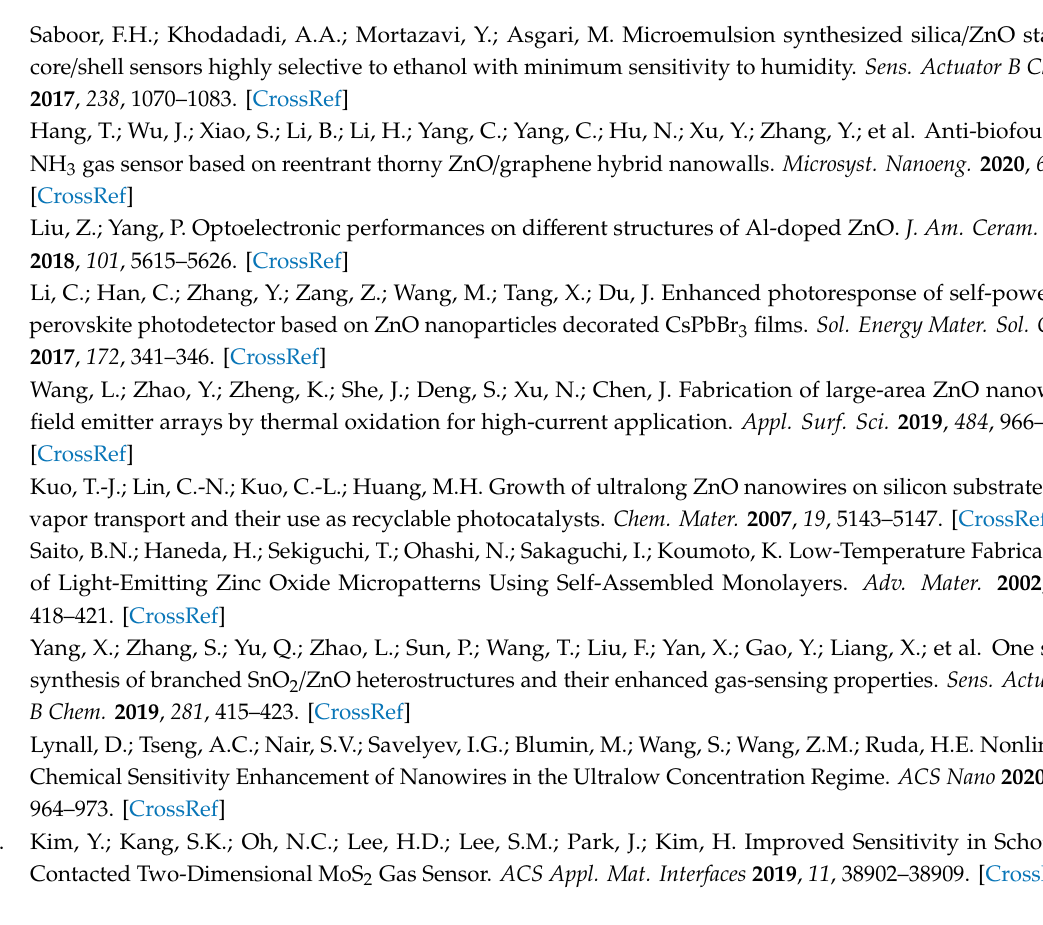
Figure S1: Photograph of the gas sensor. Figure S2: Dynamic response curve of resistance. Figure S3: Nitrogen adsorption and desorption isotherm of ZnO-1 (a) and ZnO-3 (b). (The insets are pore size